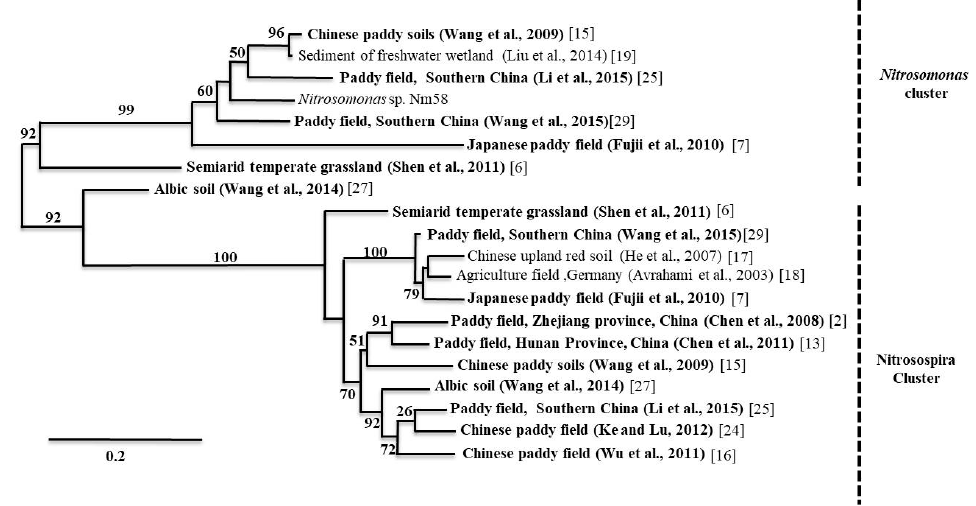
Figure 1. Neighbor-joining phylogenetic trees of AOB (ammonia-oxidizing bacteria) based on amo A gene sequences found in different paddy soil types, where the end nodes of the tree represent soil types. Please see the provided references for more details. In addition, please note that we performed bootstrapping to yield 1000 replicates at each node. Environments 2017 , 4 , 84